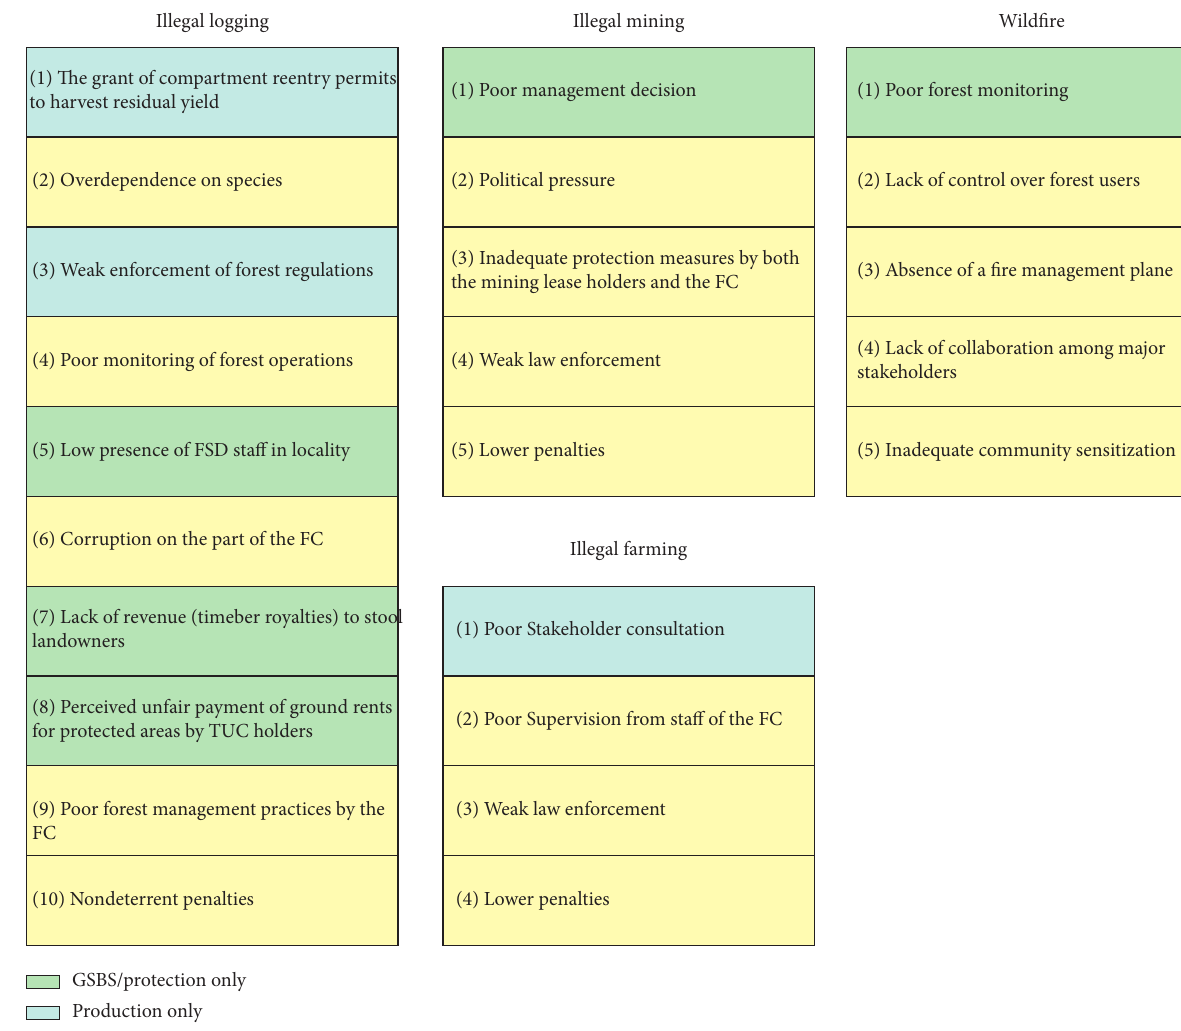
Figure 2: Underlying drivers of forest degradation in various management